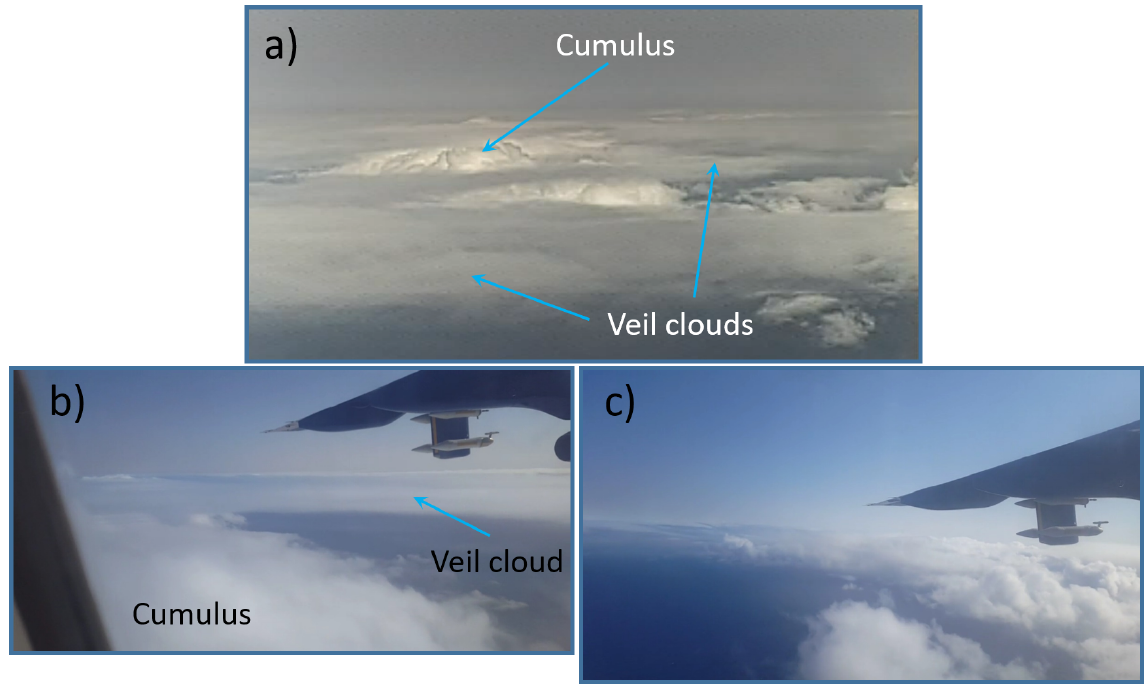
Figure 6. Photographs taken from the FAAM aircraft on flight C052. Photo (a) is from the aircraft rearward-facing camera on profile P1 at 15:44UTC, as the aircraft headed westwards on the initial descent into the POC. This was just above the boundary layer at an altitude of 2286m and at 8.3 ◦ W. Photos (b, c) are from the return low-level leg. Photo (b) was taken at 16:12UTC, 10.2 ◦ W, at an altitude of 1847m as the aircraft climbed above the boundary layer on profile P4. Photo (c) was taken at 16:25UTC, 11.0 ◦ W, within the ultra-clean layer on profile P6 at an altitude of 1240m. This is where the enhanced aerosol concentration measured on the CPC was observed in the ultra-clean layer (UCL) (see Fig. 5b). Photographs (b, c) are courtesy of Ross